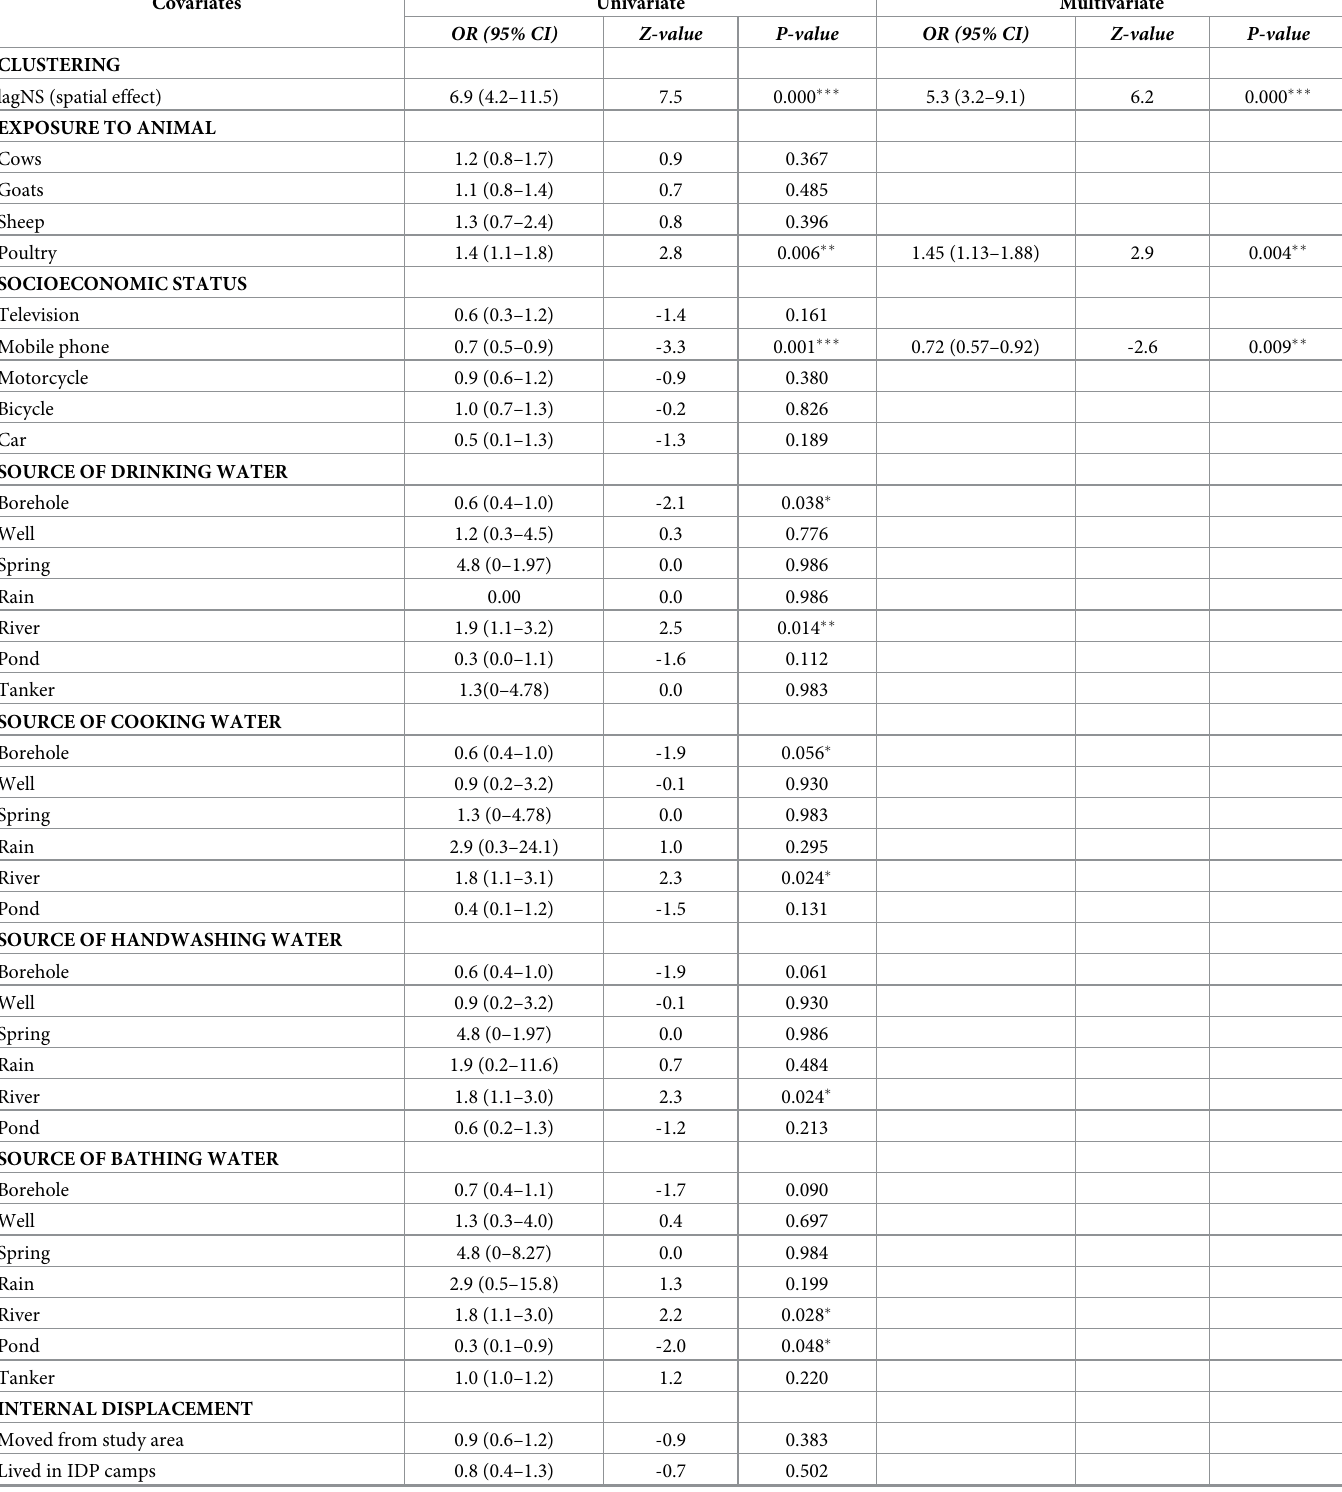
Table 3. Univariate and multivariate analysis of risk factors for nodding syndrome, South